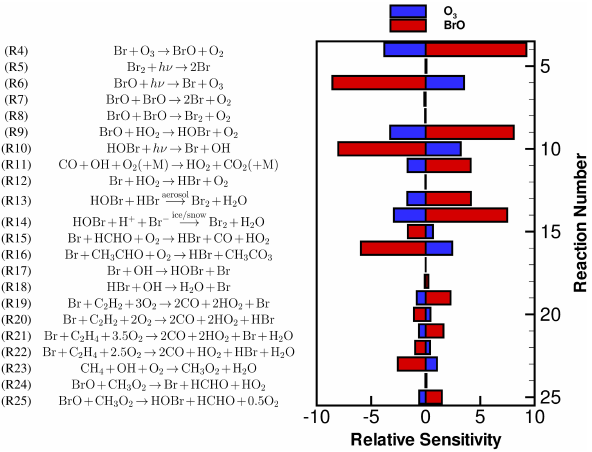
Fig. 6. Instantaneous relative sensitivities of mixing ratios of ozone and BrO for bromine-containing reactions at day 6 for a 200m boundary layer height.